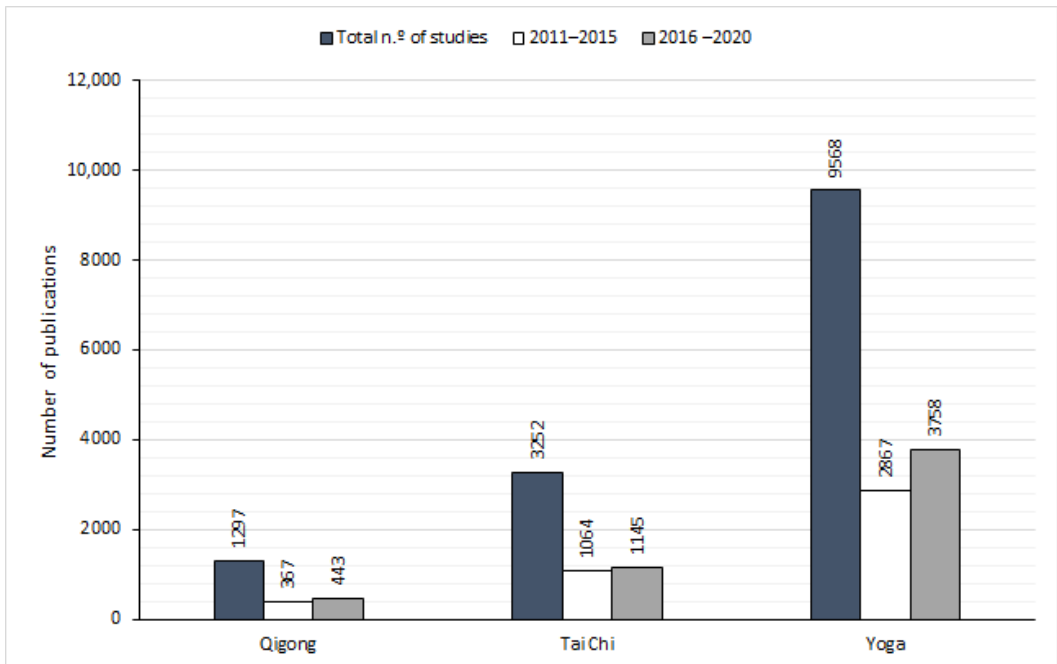
Figure 1. Graphical representation of the analytical data collected from the literature search showing the total number of publications per traditional heath practice (source Web of Science). the total number of publications per traditional heath practice (source Web of